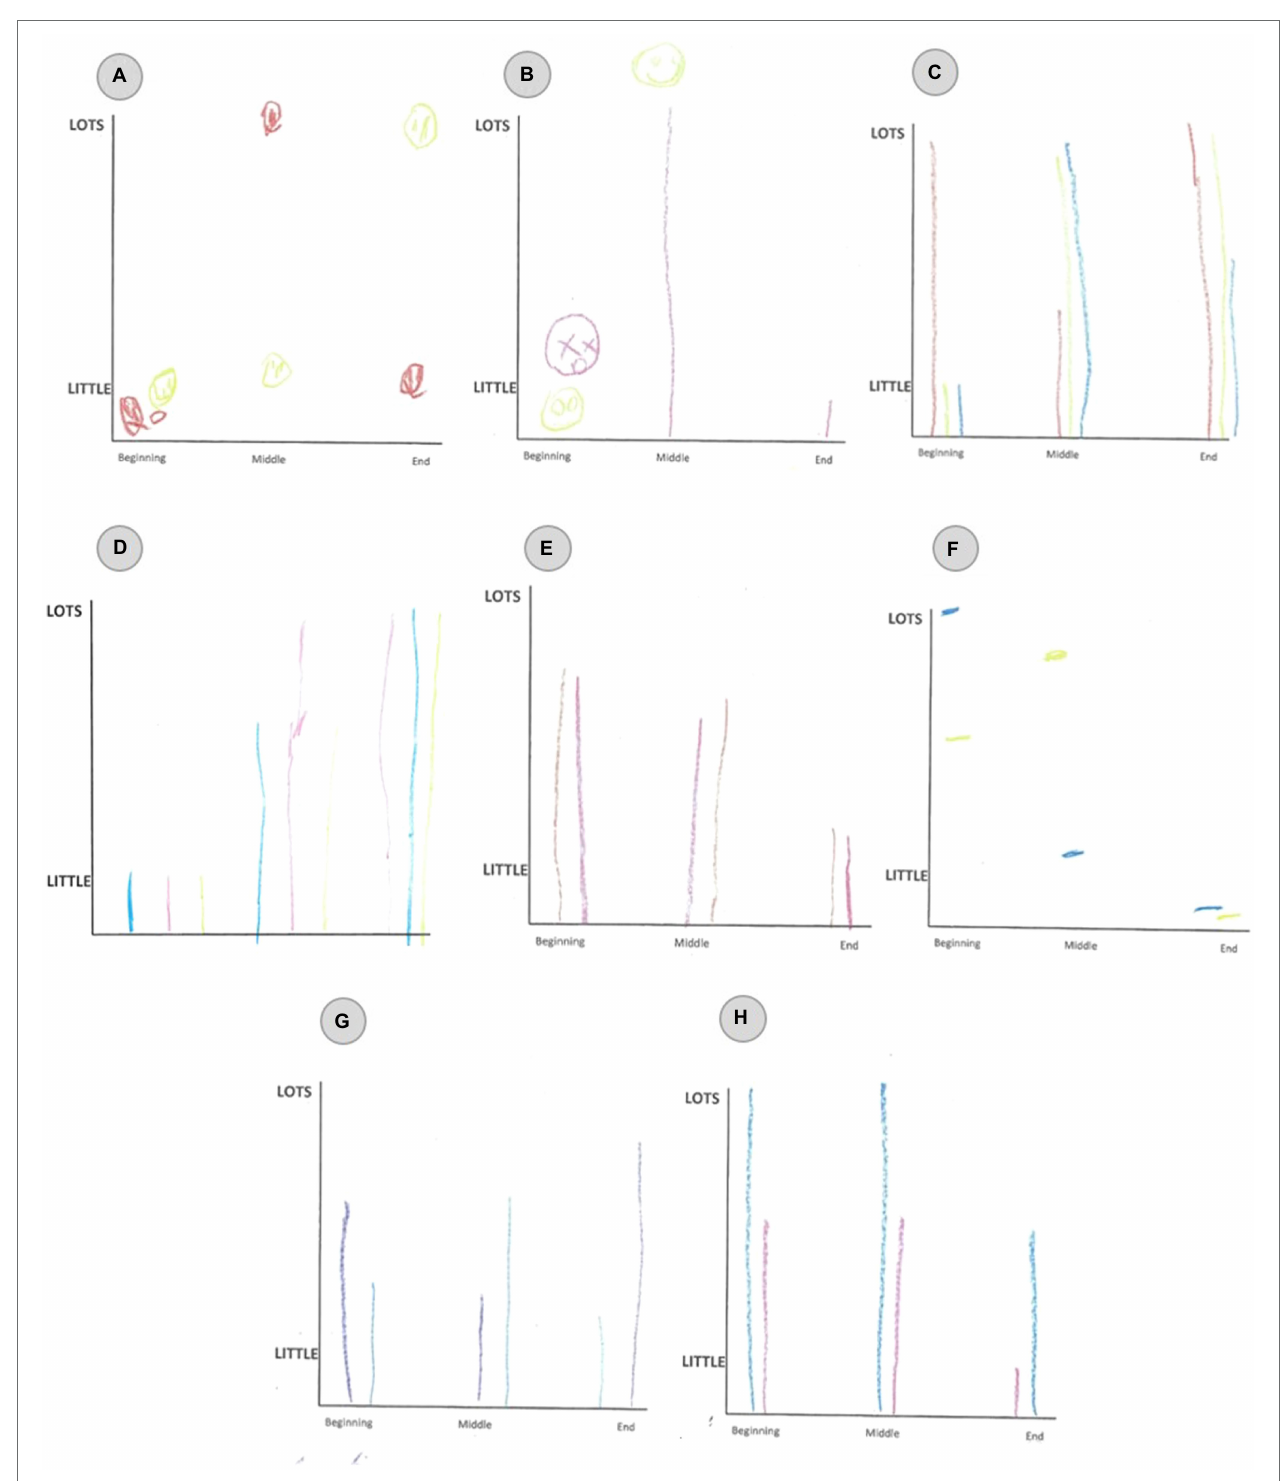
FIGURE 5 | Examples of ‘false single’ emotions AES patterns as drawn by the participants. (A) was produced by a 5 year old male participant. The red colour represents calm and yellow represents happy. (B) was produced by a 5 year old female participant. The pink represents surprise and yellow represents happy. (C) was produced by a 9 year old female participant. The blue represents calm, red represents surprise and yellow represents happy. (D) was produced by an 8 year old male participant. The pink represents worry, blue represents sad, and yellow represents fear. (E) was produced by an 8 year old male participant. The brown represents worry and the pink represents sad. (F) was produced by a 10 year old male participant. The blue represents fear and yellow represents worry. (G) was produced by an 8 year old female participant. The blue represents sad and purple represents calm. (H) was produced by a 7 year old female participant. The pink represents worry and blue represents